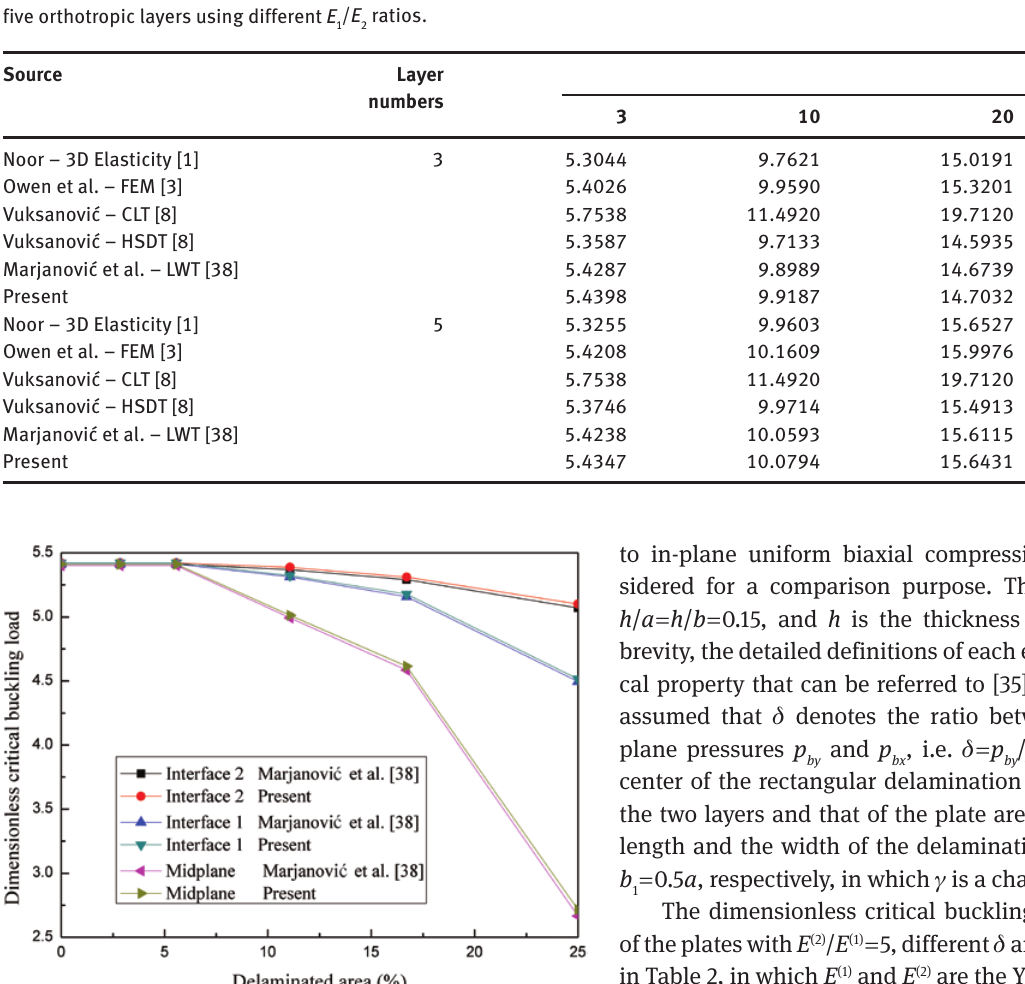
Table 1: Comparison of dimensionless critical buckling loads of the intact (0/90/0 … ) simply supported square laminates with three and five orthotropic layers using different E